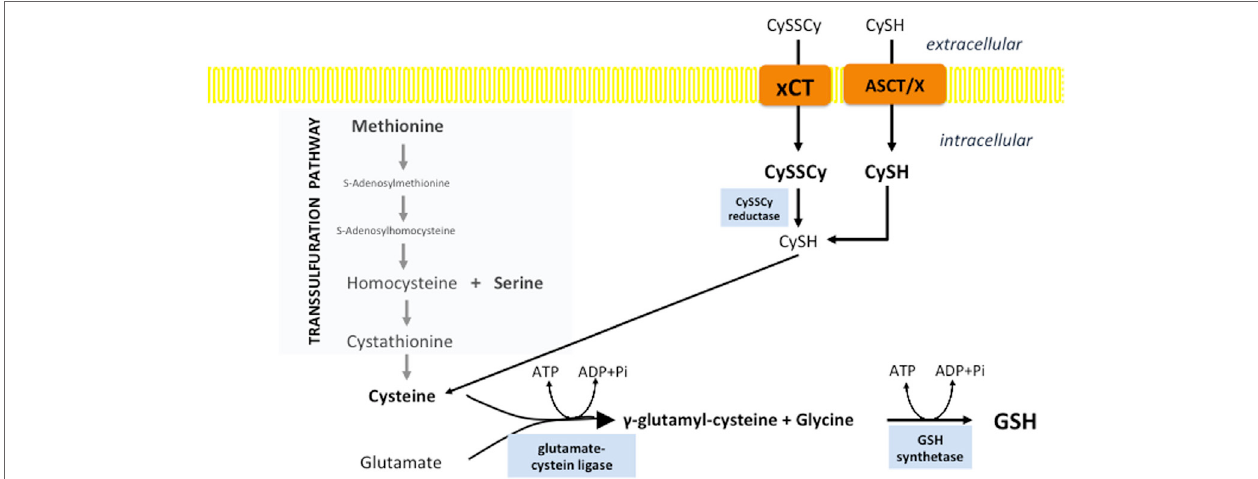
FiGURe 2 | Cystine import is the rate-limiting step in glutathione biosynthesis. Cysteine can be synthesized within the cell through the trans-sulfuration pathway. However, this pathway is often insufficient in cancer cells and therefore cysteine must be imported. Different transporters are involved in the import of the reduced, cysteine (CySH), and oxidized, cystine (CySSCy) form of this semi-essential AA. The heavy-chain transporter subunit of system x c -light chain (xCT) seems to play a pivotal role in the import of CySSCy, the predominant form of cysteine in circulation. After import, CySSCy is reduced by cystine reductase and used for different purposes including GSH biosynthesis. Import of cysteine can occur via ASCT (alanine/serine/cysteine transporter) and other transporters